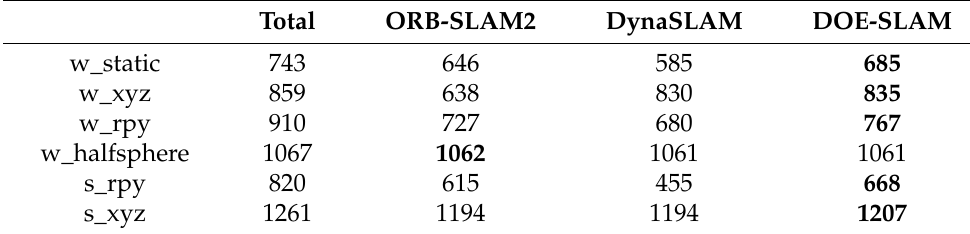
Table 6. Comparison of the number of tracked frames in selected TUM